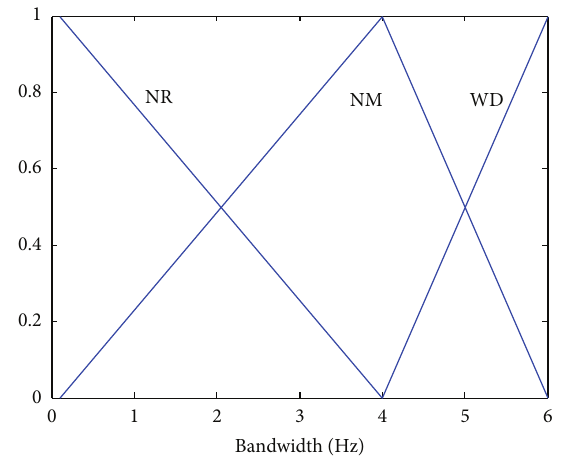
Figure 2: PLL bandwidth